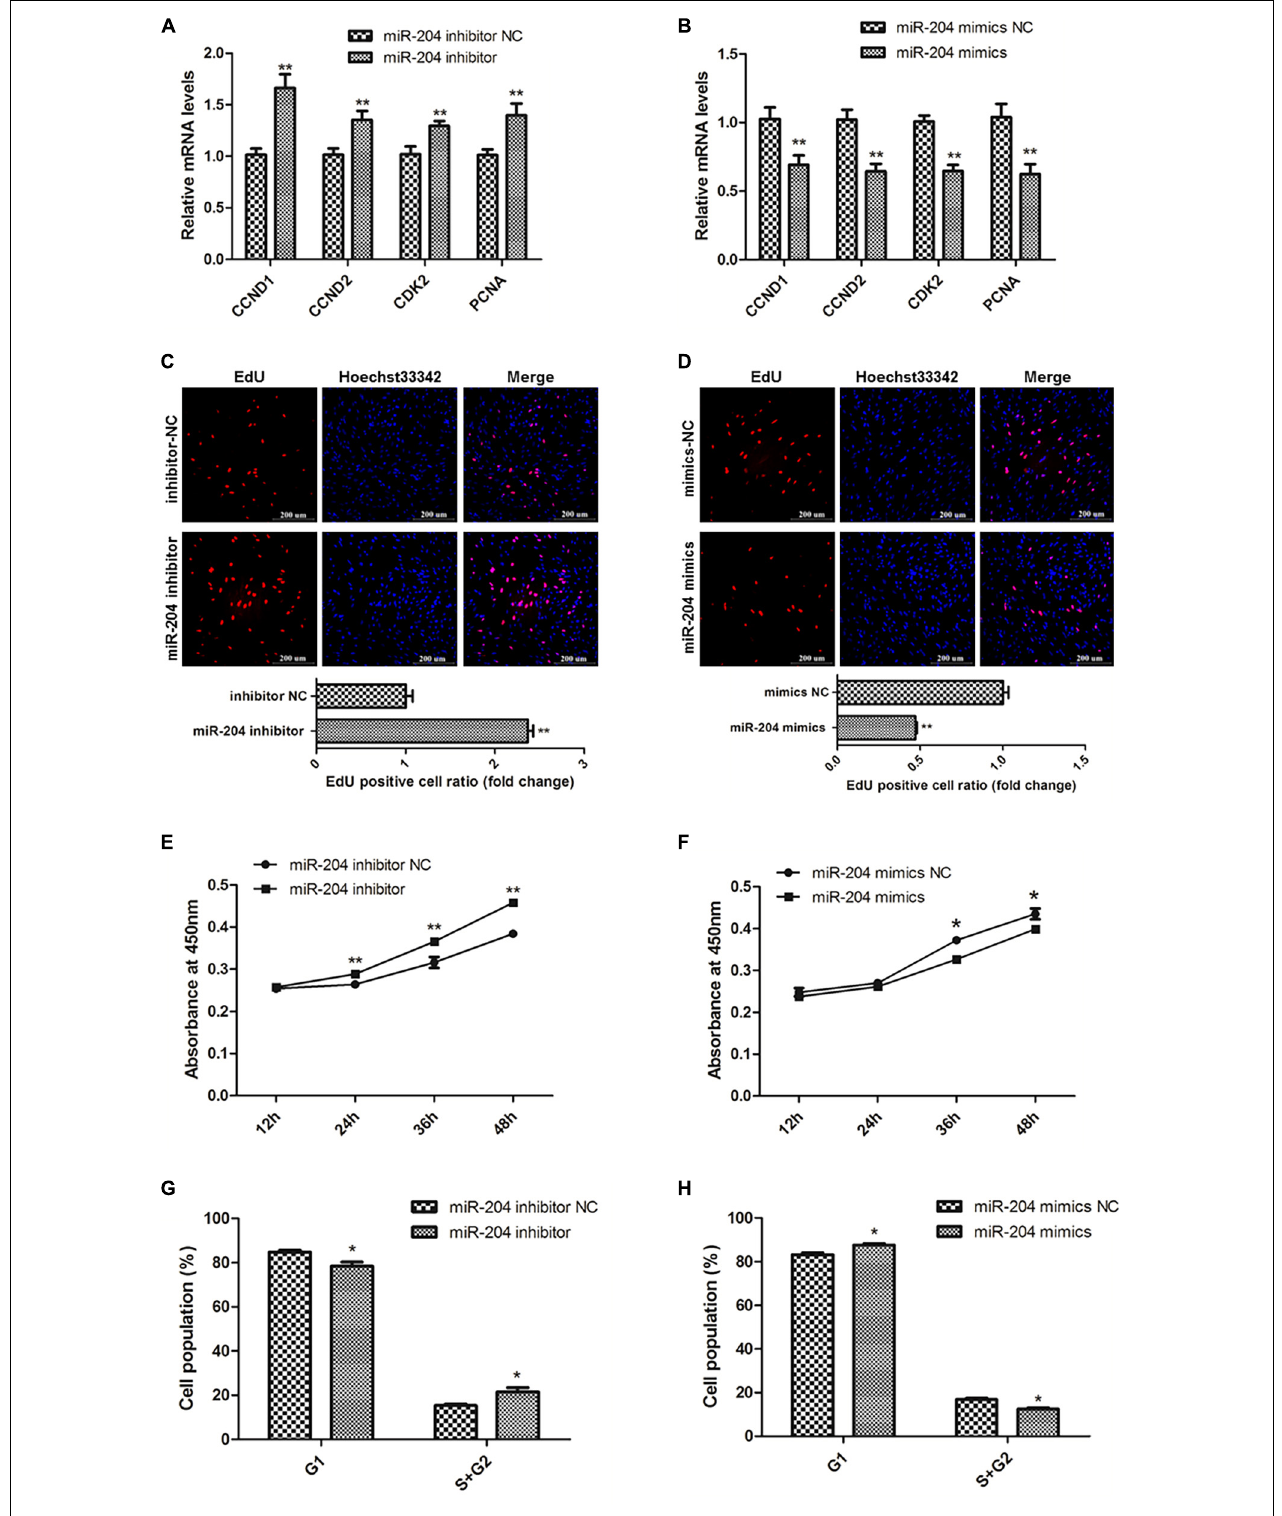
FIGURE 5 | MiR-204 represses the proliferation of SMSCs in chicken. (A,B) Proliferation-related genes mRNA levels were determined using qPCR after SMSCs were transfected with miR-204 inhibitor or mimics. (C,D) EdU assays were conducted after the cells were transfected with miR-204 inhibitor or mimics. (E,F) SMSCs absorbance at 450 nm was detected by CCK-8 assay after the cells were transfected with miR-204 inhibitors or mimics. (G,H) Cell cycle analysis of SMSCs following miR-204 overexpression or inhibition. The scale bar represents 200 µ m. Values represent as means ± S.E.M. of three biological replicates. * P < 0.05; ** P < 0.01.